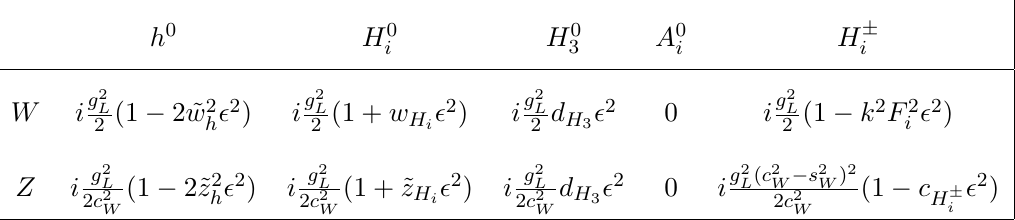
Table 13 . Couplings of W (cid:11) W (cid:12) and Z (cid:11) Z (cid:12) with various scalars. The expressions of the various